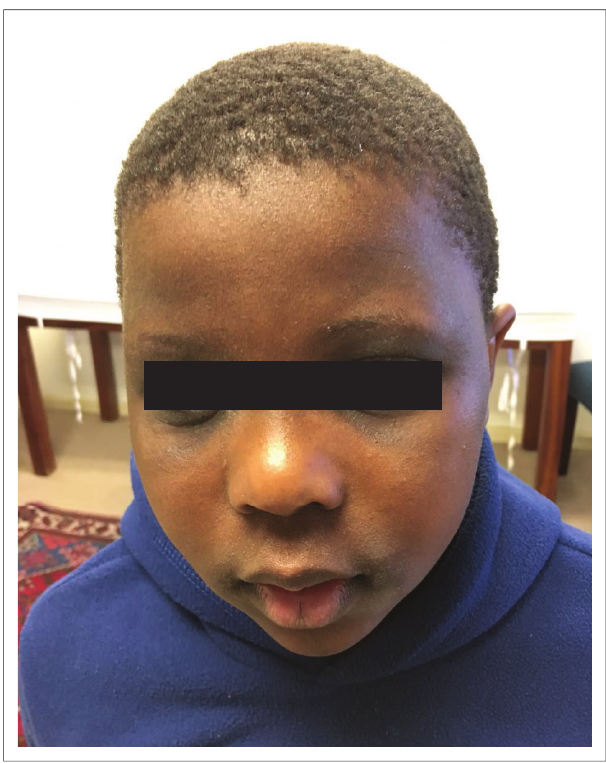
FIGURE 3: Features of an allergic face. (With permission from the child and